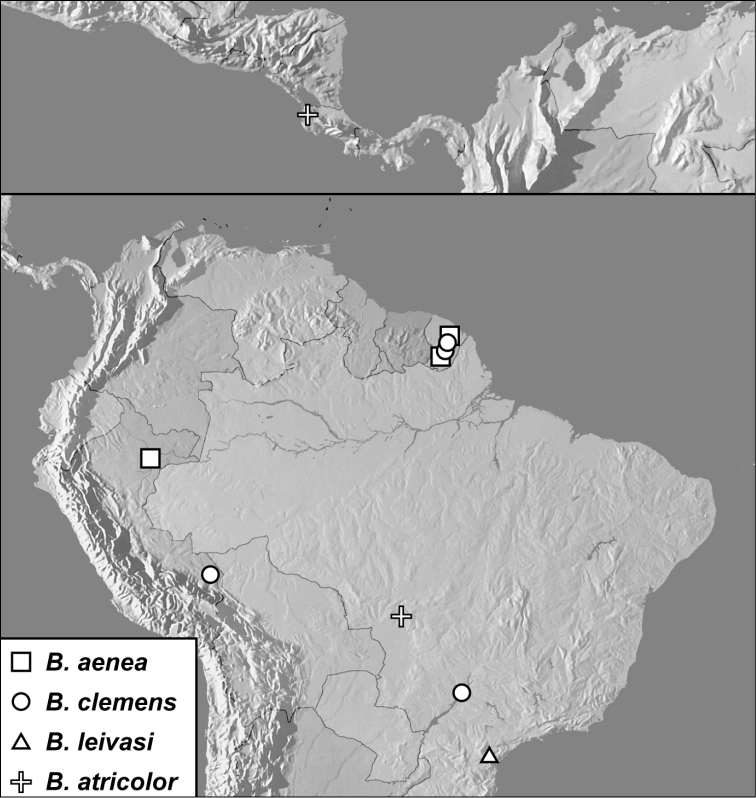
Baconia incertae sedis records.